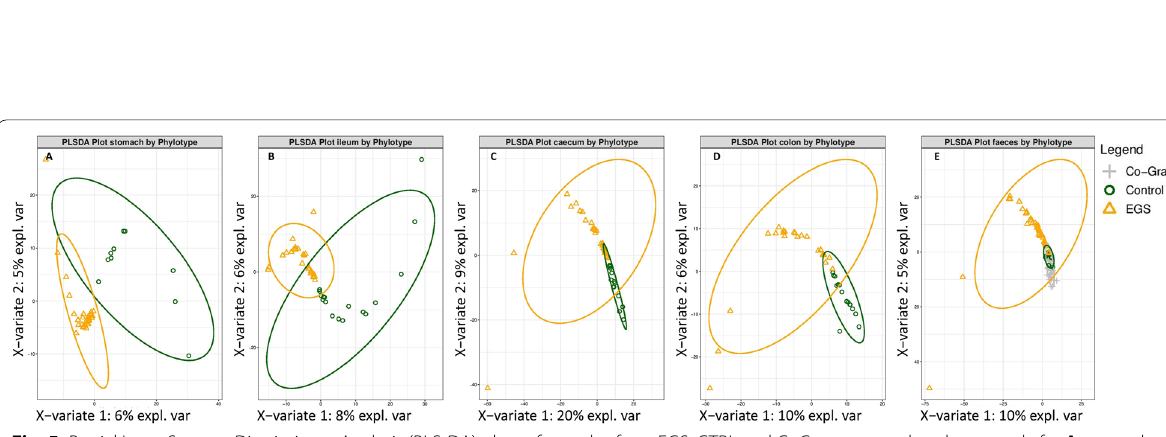
Fig. 5 Partial Least Squares Discriminant Analysis (PLS-DA) plots of samples from EGS, CTRL and CoG groups, analysed separately for A stomach, B ileum, C caecum, D colon and E faeces. Weighted UniFrac distance analysis identified significant inter-group dissimilarities (Additional file